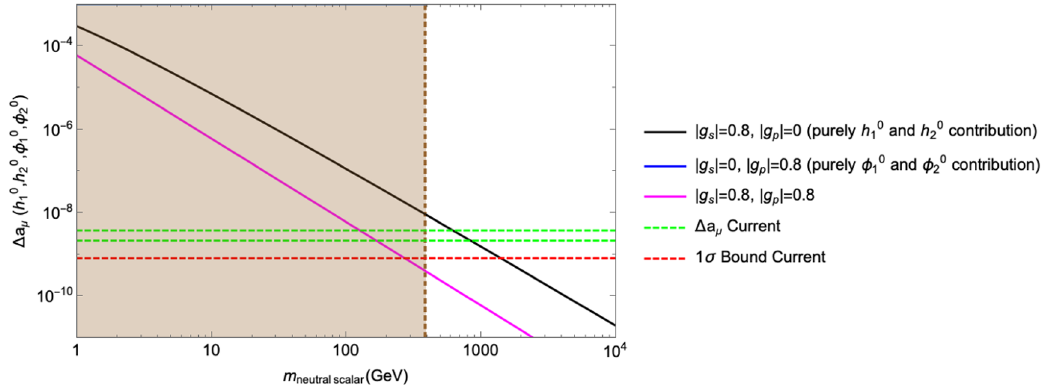
Figure 12 . Plot showing the contributions of CP-even and CP-odd neutral scalars to (cid:1) a (cid:22) . The black line represents purely scalar contribution coming from h 0 the combination of both scalar as well as pseudoscalar couplings. For purely pseudo-scalar coupling the contribution becomes negative (we have not shown it in this plot). Brown shaded region indicates the excluded mass range for neutral